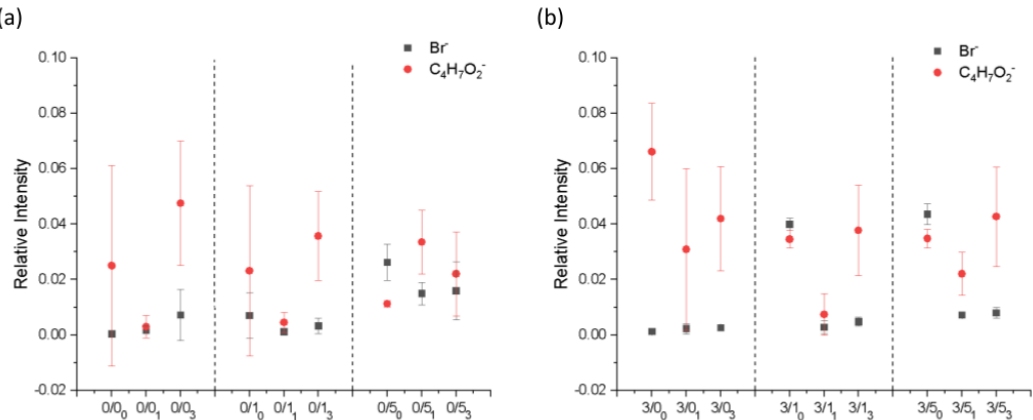
Figure 3. Relative intensities of Br − and C 4 H 7 O 2 − ions as a function of sample type for PLA films after degradation for 1 and 3 months. ( a ) PLA doped with CTAB; ( b ) PLA doped with magnesium and CTAB. All data are given as mean and standard deviation.